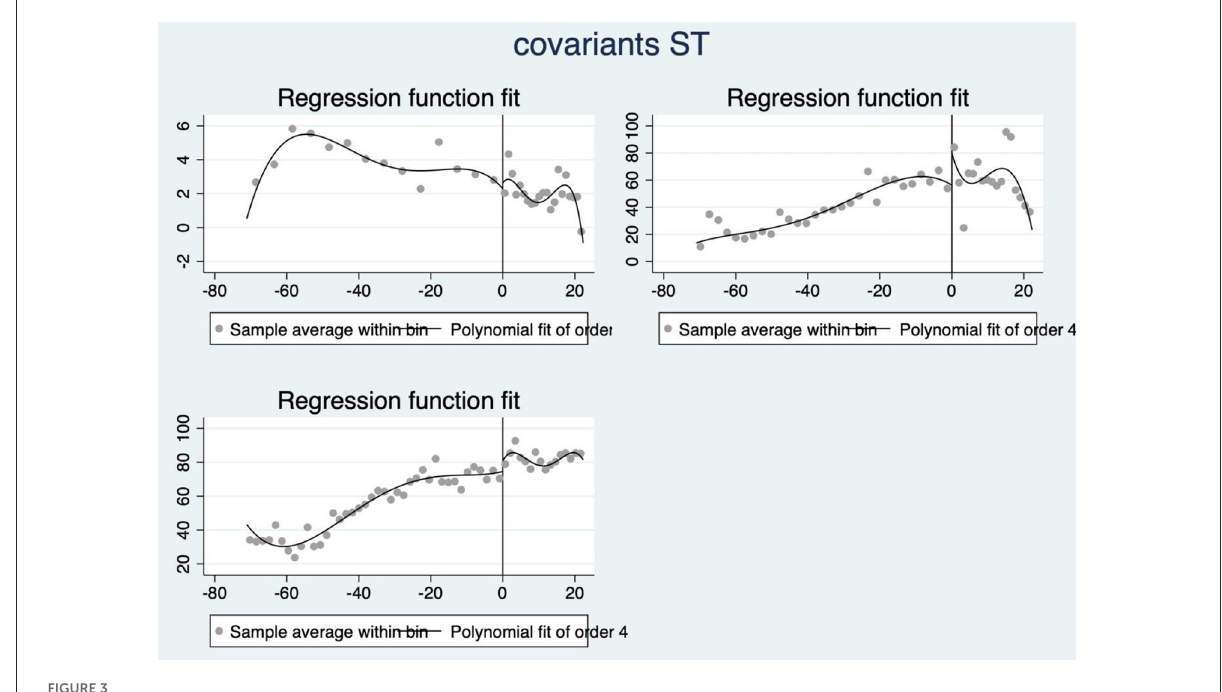
FIGURE3 Smoothness test of covariant.